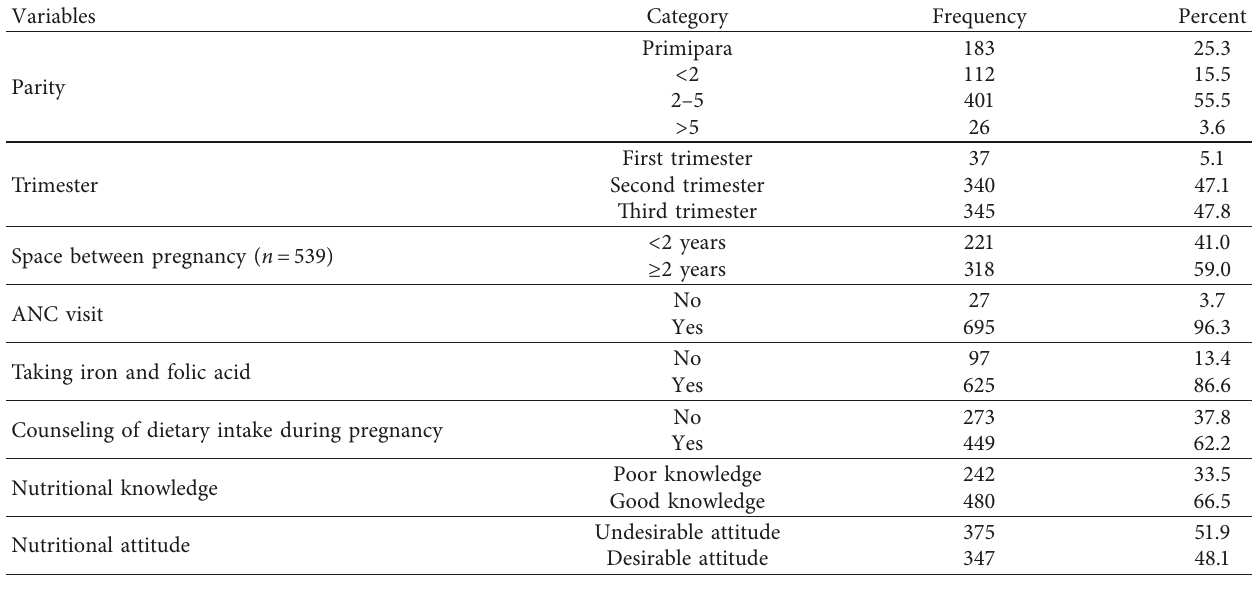
Table 3: Obstetric characteristics of pregnant women in the Gurage zone, southwest Ethiopia, September to November 2021 ( n � 722). Variables